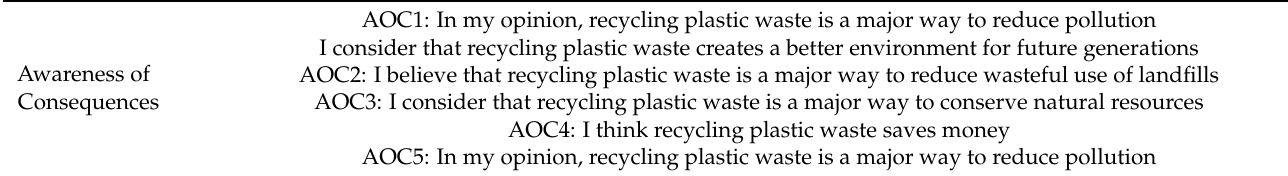
Table A1. Measurement items of each